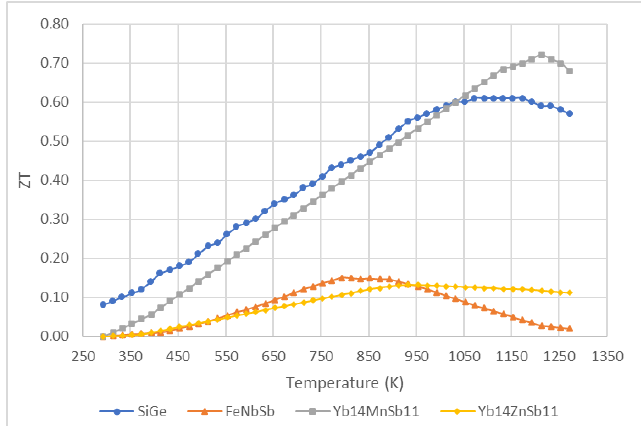
Figure 7. The thermoelectric performance of market standard thermoelectric materials over the high-temperature range: Yb 14 MnSb 11 records a ZT value of 0.72 at 1193 K and an efficiency of 15.66% at 1233 K. Silicon-germanium (SiGe) is the next best performing material, with a peak ZT of 0.61 that is maintained from 1073 K to 1173 K and a peak efficiency of 13.70% at 1233 K. Neither Yb 14 ZnSb 11 nor FeNbSb record a ZT value over 0.15 but FeNbSb behaves like the majority of half-Heusler structures with a high power factor, reaching 5 mWm −1 K −2 .